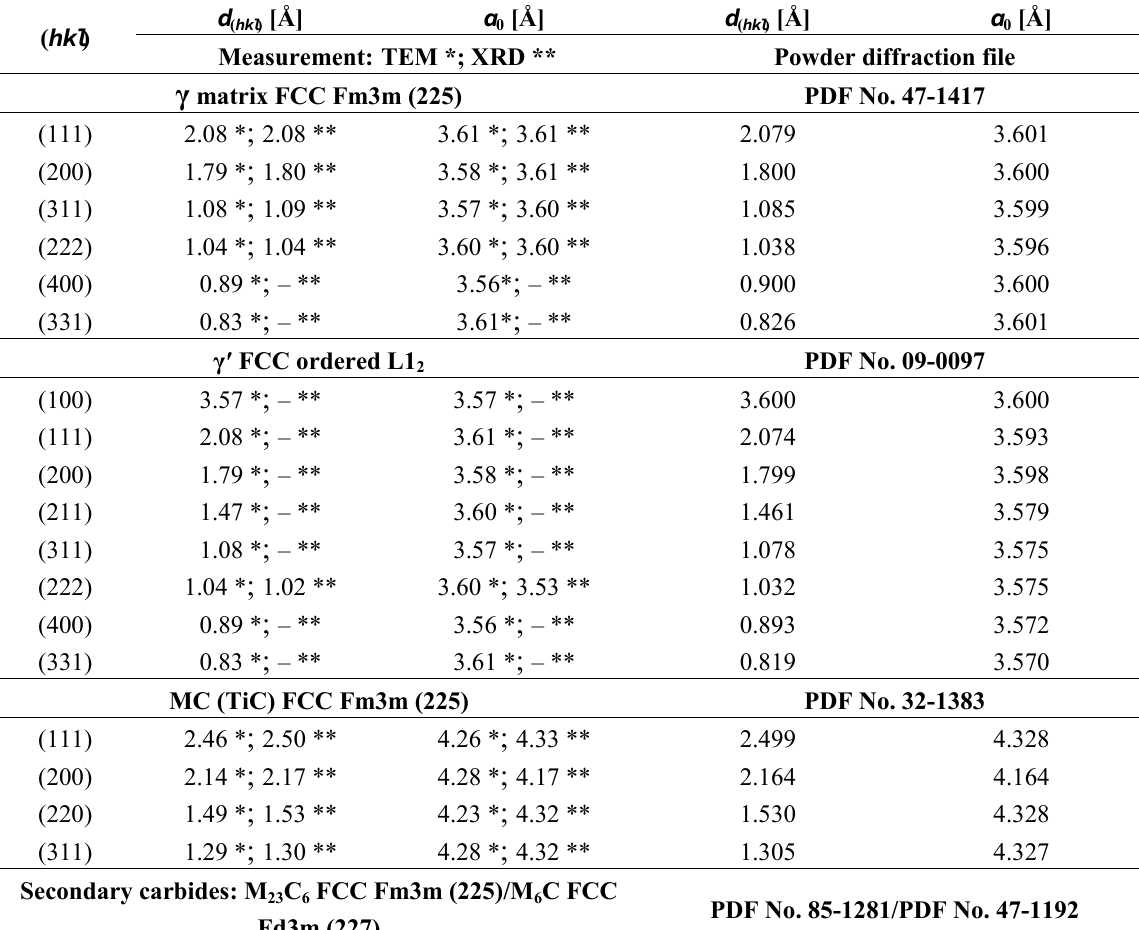
Table 2. The measured values of d carbides (MC) and secondary carbides phases in the as-cast Haynes ® 282 ®